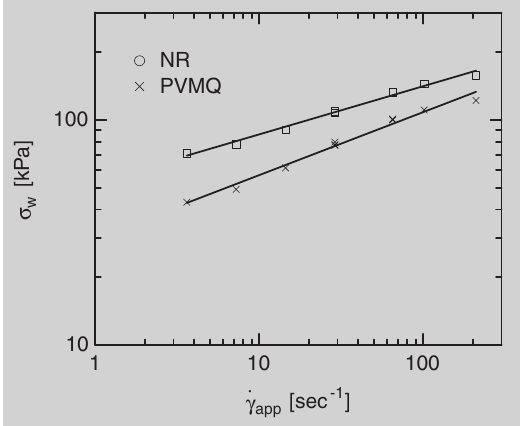
Figure 1 (left): Flow curves for NR (110˚C, s w = 52.7 g · app 0.214 ) and PVMQ (120˚C, s w = 29.8 g · app 0.28 ) compounds. Figure 2 (right): Entrance pressure from capillary rheometer characterization of NR (110˚C, Pent = 132 g · app0.45 ) and PVMQ (120˚C, P ent = 9.52 g · app0.835 ) com- pounds.